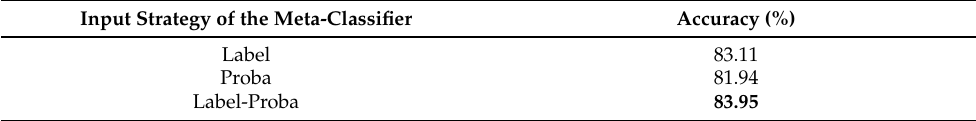
Table 15. Influence of the meta-classifier’s different input strategies on classification